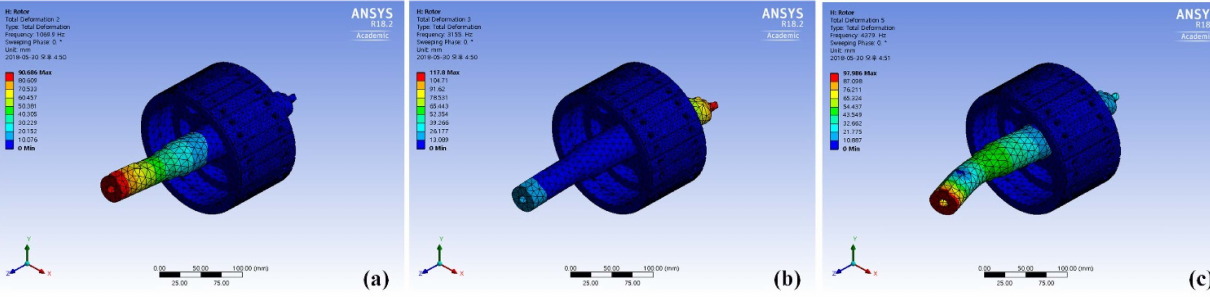
Figure 13. Modal analysis for the rotor with the shaft: ( a ) first, ( b ) second, and ( c ) third